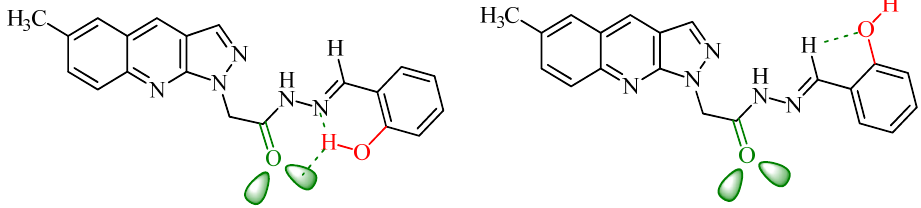
Figure 6. Possible intramolecular interactions in E (C=N) (N-N)— Antiperiplanar form of 6q . 13 C NMR spectra of the synthesized compounds 6 ( a – t ) too, displayed duplicated sig-